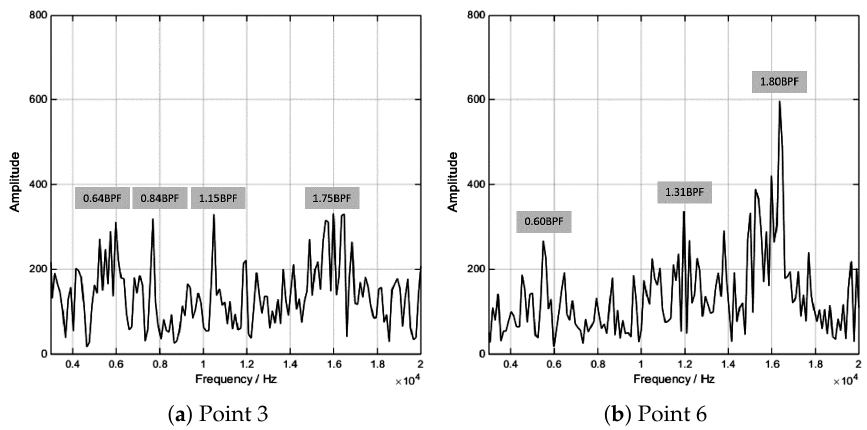
Figure 11. Amplitude spectrum of certain monitor points at